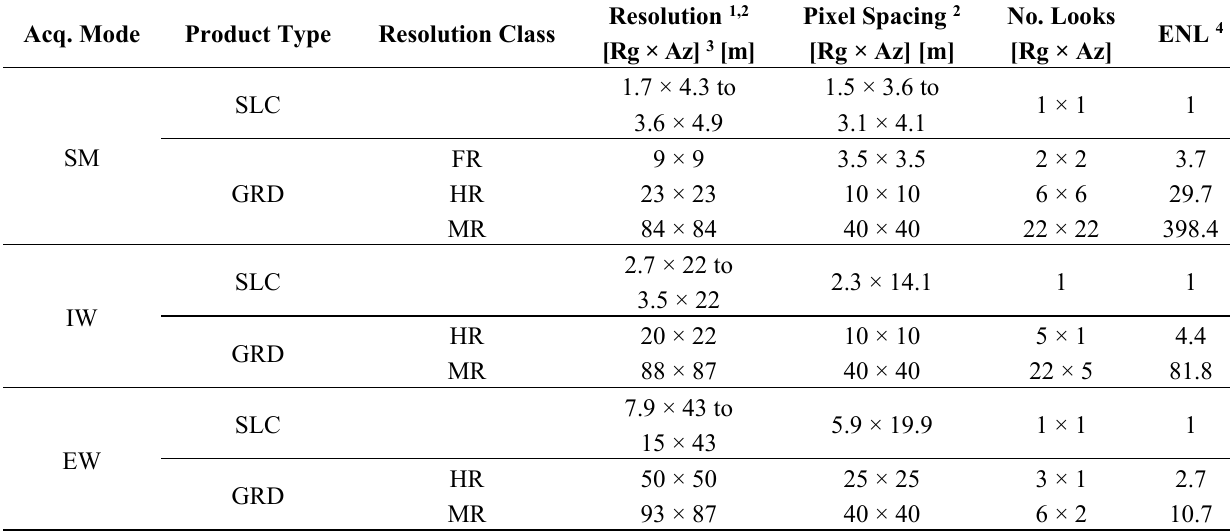
Table 1. Level 1 Product Family Summary; adapted from Table 5-1 in